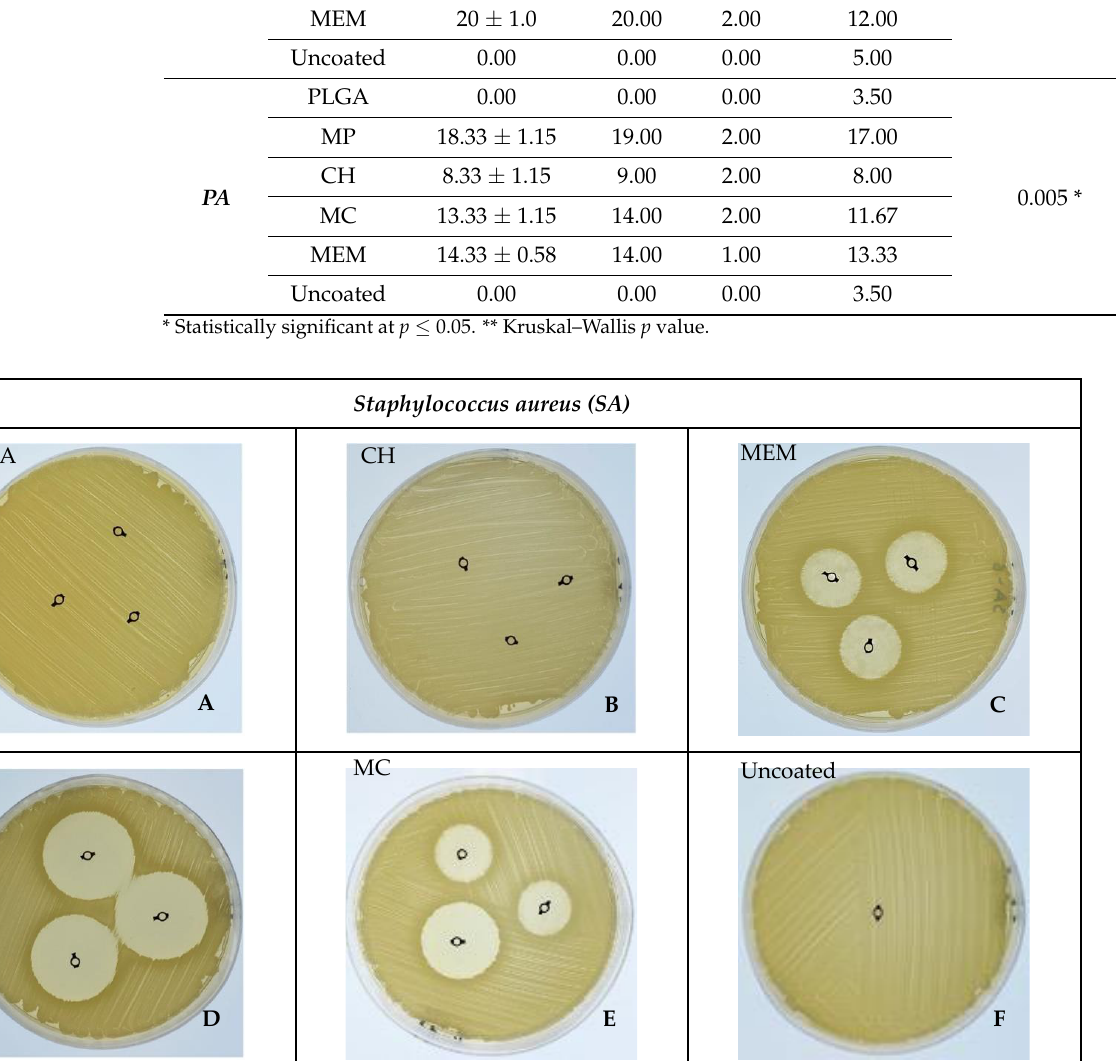
Figure 2. CFU count for SA and PA against the tested materials.